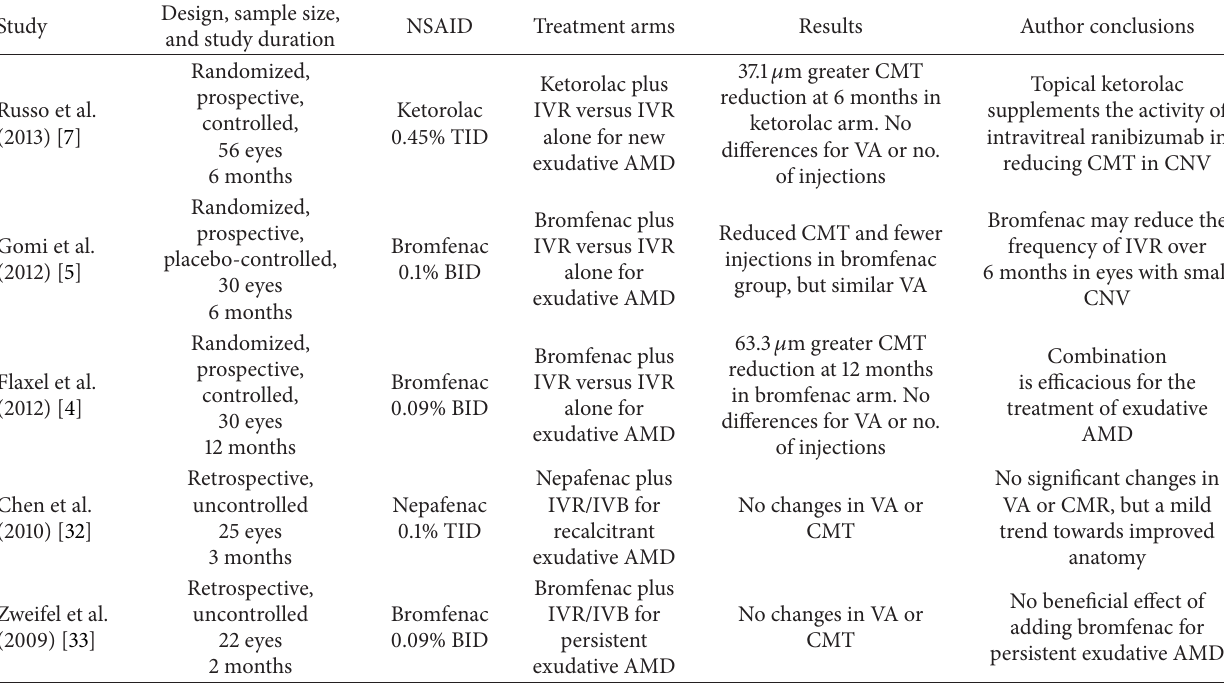
Table 2: Studies investigating NSAIDs in combination with